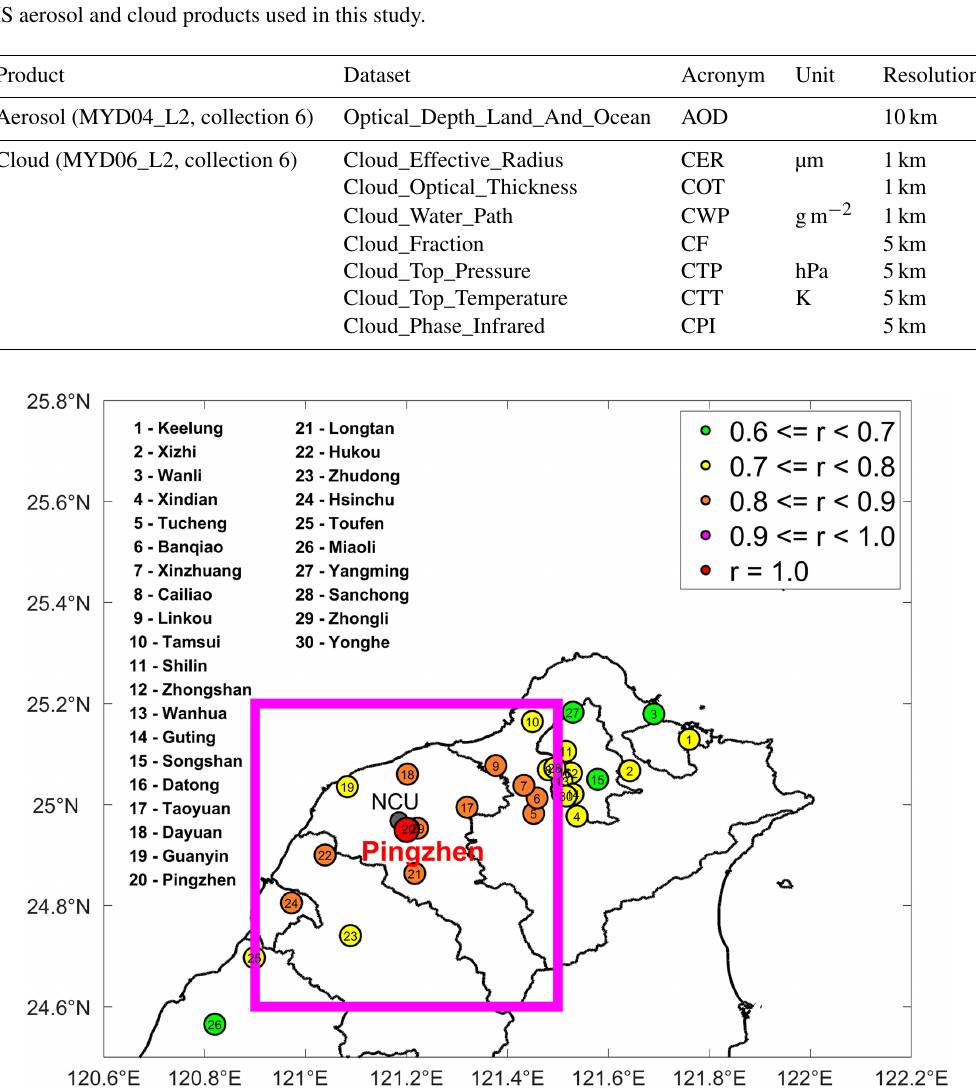
Figure 1. Spatial correlation coefficient of the PM 2 . 5 concentration between the Pingzhen station and other stations. The main research area (24.6–25.2 ◦ N, 120.9–121.5 ◦ E) is indicated with a magenta